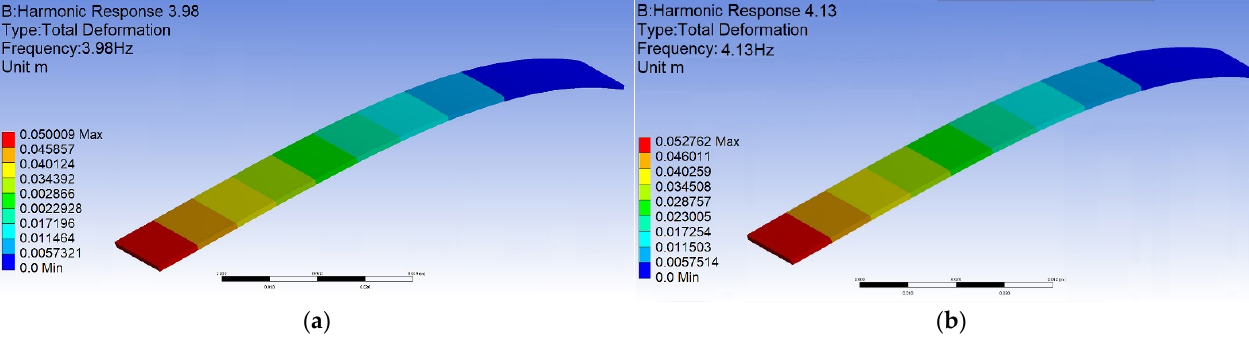
Figure 7. Displacement of the 10 cm elastic steel ( a ) excited by linear frequency, ( b ) excited by non- linear frequency.